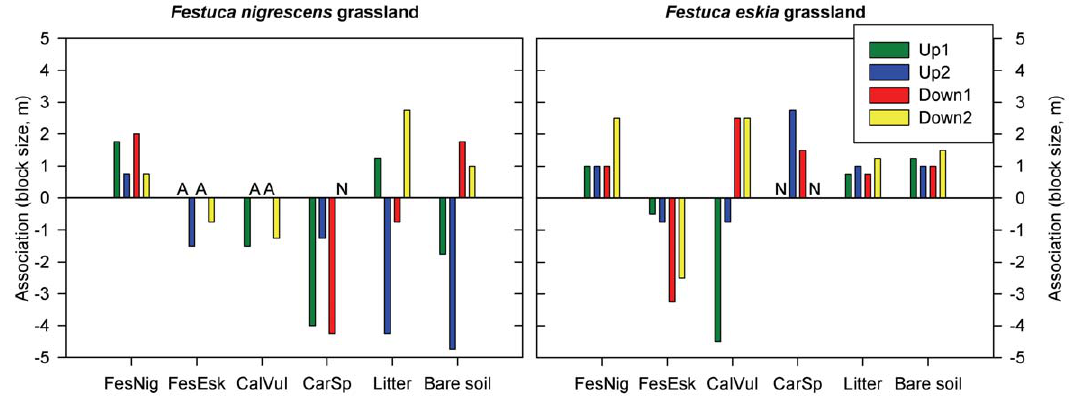
Figure 3. Scales of positive and negative associations between juvenile Cytisus and each cover type in F.nigrescens or F.eskia grasslands. Cover type: FesNig = Festuca nigrescens ; FesEsk = Festuca eskia ; CalVul = Calluna vulgaris ; CarSp = Carex sp. ( A =cover type absent in the plot; N =association is non-significant below 5 m). All the scales of association except those indicated ( N ) are significant ( p , 0.05) based on randomization tests used to build a null covariance model and the associated 95% confidence